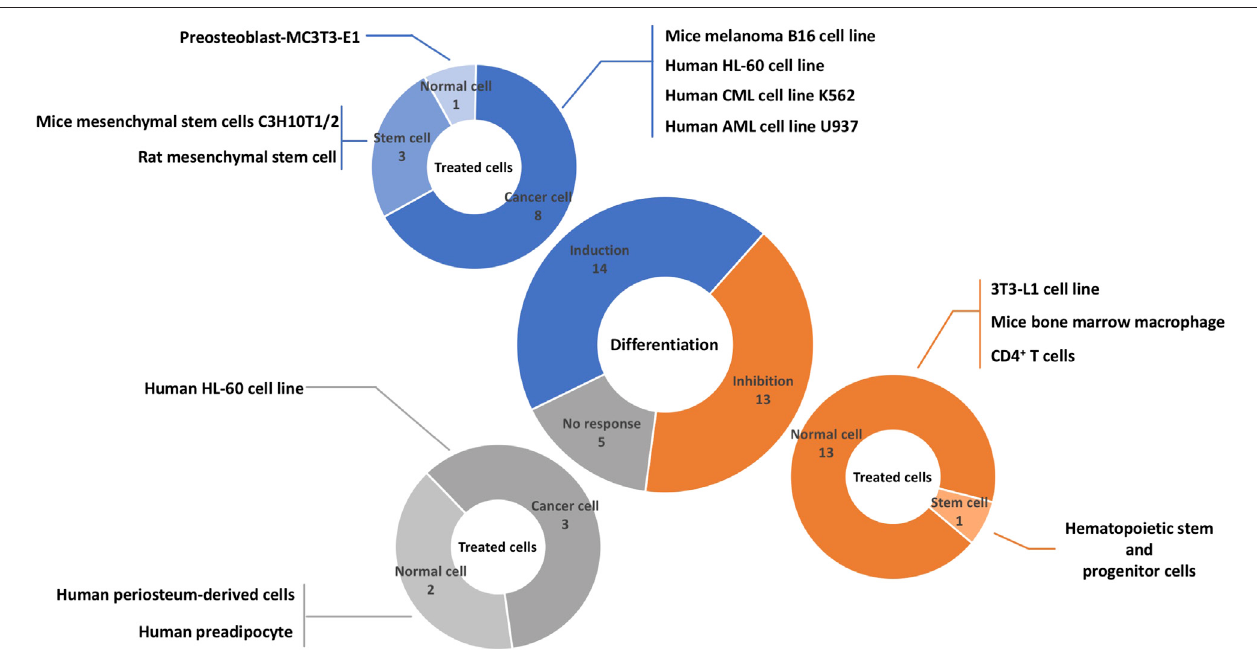
FIGURE 3 | Overview of literature on the effects of sesquiterpene lactones on differentiation and affected cells. Sesquiterpene lactones either induced differentiation, inhibit it, or had no effect. The effects of sesquiterpenelactones were evaluated in normal and cancer cell lines and stem cells. The numbers represent the experiments and not